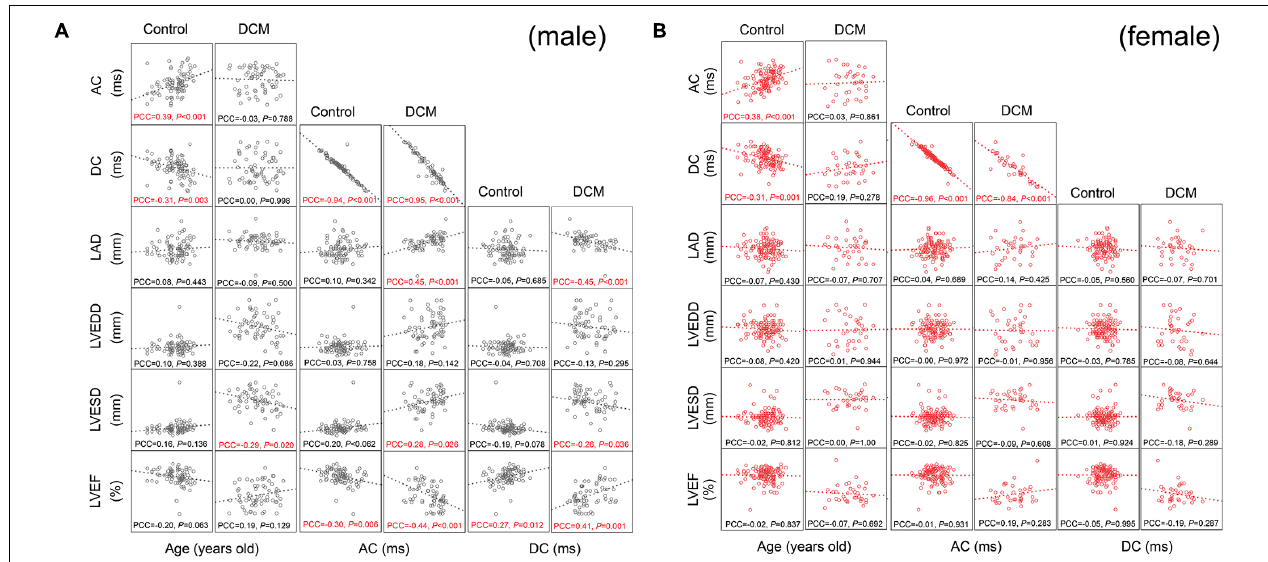
FIGURE 2 | Scatter plot matrix and Pearson’s correlation coefficients among variables. The associations between parameters were presented by scatter plot matrix visually together with Pearson’s correlation coefficients. The scales differed between each subunit of scatter plot matrix, so, we omitted scales of each axes. The accurate quantitative results of linear logistic regression are presented in Tables 2 , 3 . PCC, Pearson’s correlation coefficient (two-tailed P -values are presented). PCC with P < 0.05 was labeled in red. Please see Table 1 for a list of other abbreviations. (A) Scatter plot matrix and Pearson’s correlation coefficients among variables for males. (B) Scatter plot matrix and Pearson’s correlation coefficients among variables for females.